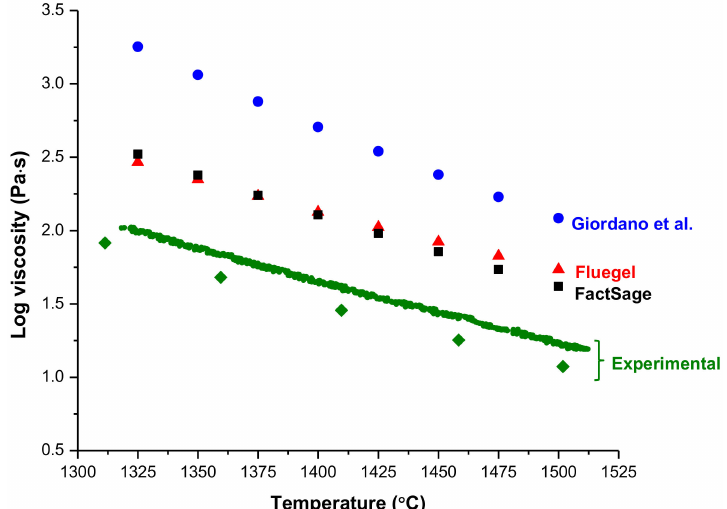
Figure 11. Viscosity curves for the volcanic ash glass used in this study based on experimental and calculated values. Calculated values were determined using the FactSage Viscosity Module and Melt Database (black squares), the Giordano et al. model (blue circles), and the Fluegel model (red triangles). Experimental data are given in green. The continuous curve is for the experimental method in which the glass was cooled at a constant 2 ◦ C / min while the separate diamond-shaped data points are for the experimental method in which the glass was equilibrated at 50 ◦ C